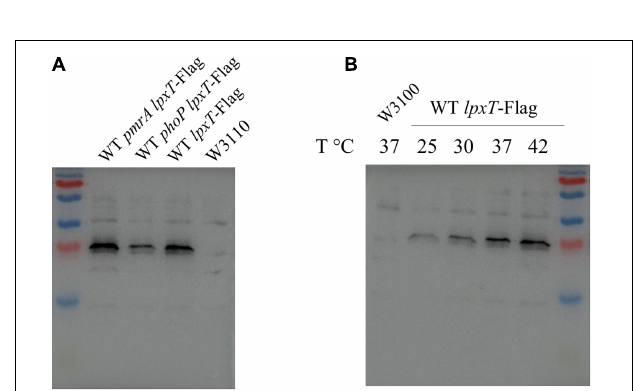
FIGURE 6 | LpxT is upregulated by PhoP and rising temperatures. The 3 × Flag tag-encoding sequence was inserted at the 3 (cid:48) end of the chromosomal copy of lpxT gene in W3110, WT pmrA and WT phoP strains. (A) The three lpxT -flag strains and W3110 were grown in 2YT medium at 37 ◦ C up to OD 600 nm = 0.7. Whole protein extracts were prepared and equal amounts of proteins according to the OD 600 nm of the culture were analyzed by Western blotting. (B) WT lpxT -flag and W3110 strains were grown in 2YT medium at 25 ◦ C before being diluted in fresh 2YT medium at OD 600 nm = 0.2 and then further incubated at 25, 30, 37, and 42 ◦ C for 1 h. Whole protein extracts were prepared and equal amounts of proteins according to the OD 600 nm of the culture were analyzed by Western blotting. The presented results are representative of three independent